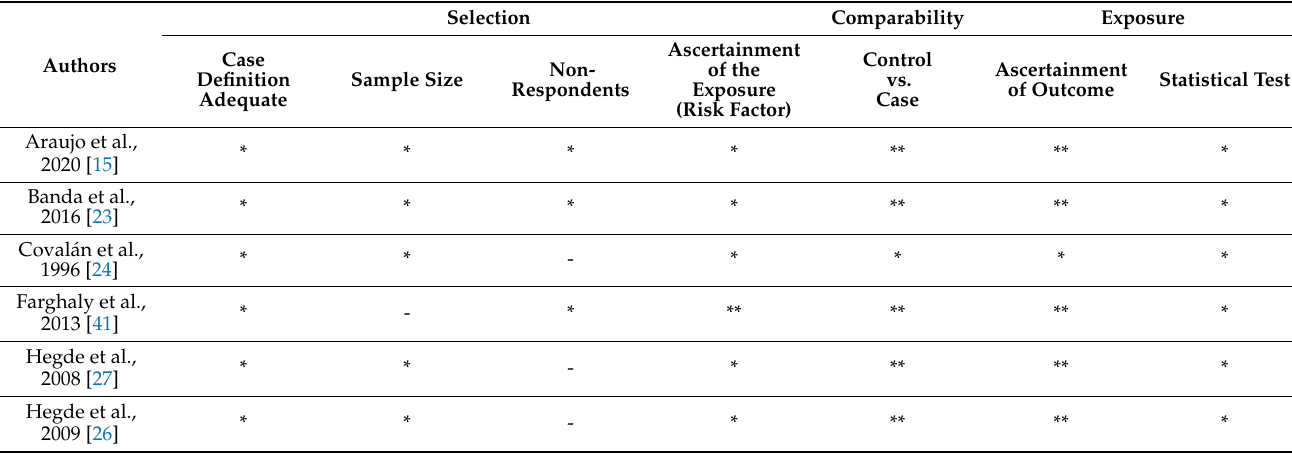
Table 3. Newcastle-Ottawa for cross-sectional